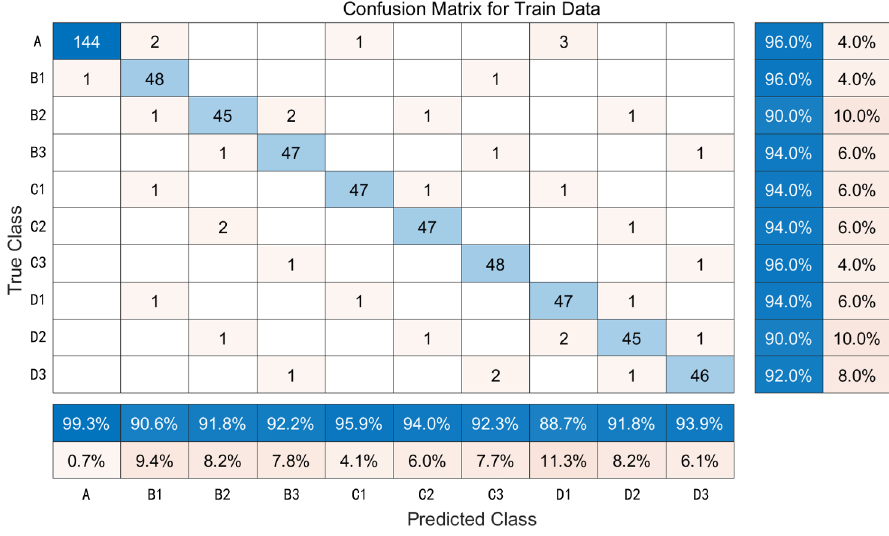
Figure 23. Diagnosis distribution and accuracy of all fault modes.